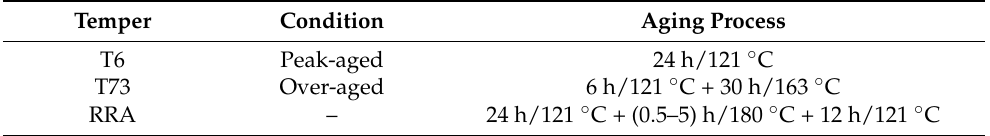
Table 1. Heat treatment procedures for studied materials. Temper Condition Aging Process